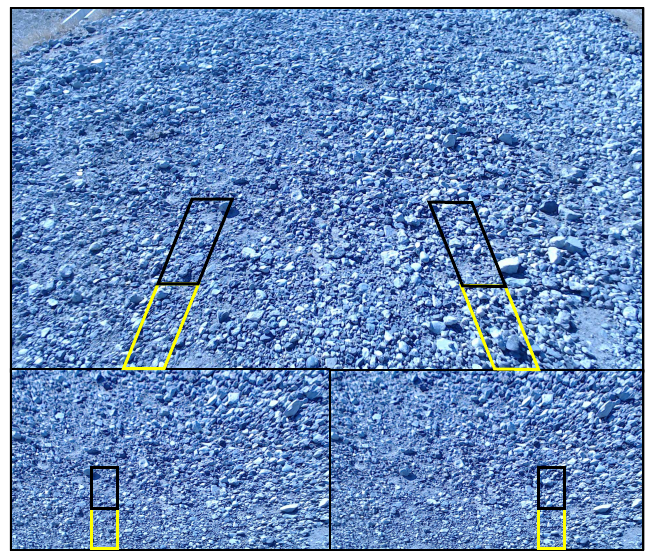
Figure 11. Identification of terrain patches for image feature